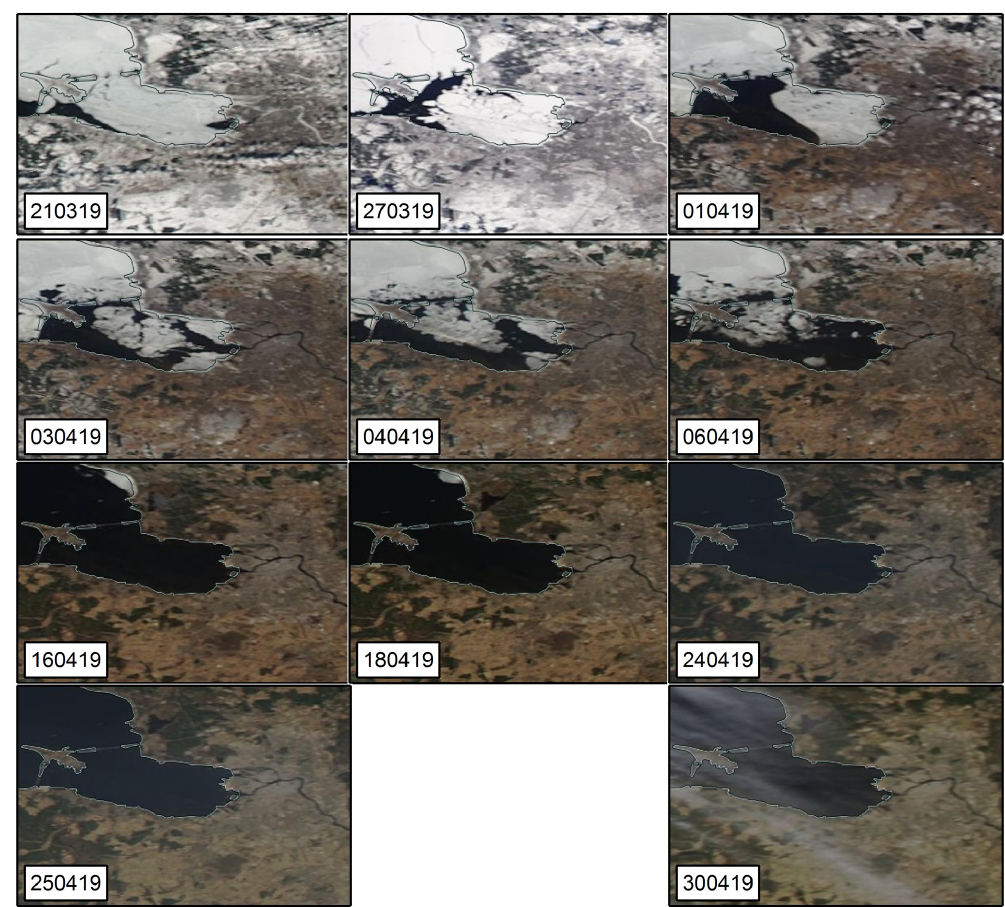
Figure A1. The MODIS satellite images of cloud cover in the vicinity of St. Petersburg taken on the days of the field campaign.